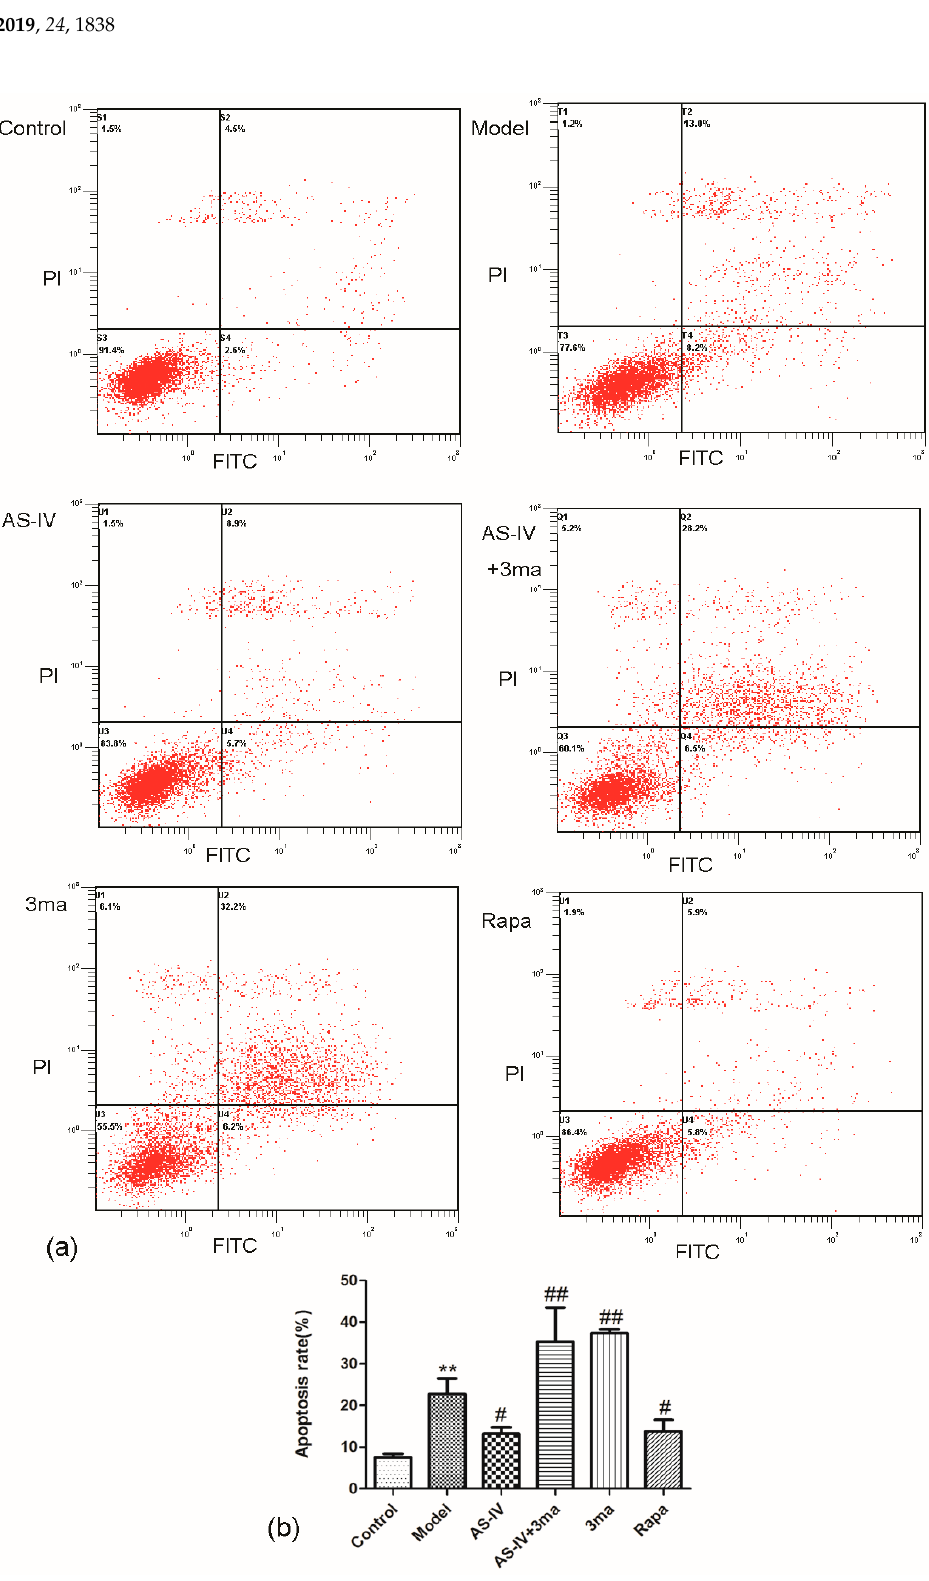
Figure 9. Astragaloside IV decreased the apoptosis rate by activating autophagy after OGD/R. The changes of the apoptotic rates in the HT22 cells by OGD/R with different treatments examined via flow cytometry with Annexin V-FITC/PI staining (means ± SD, n = 3. ** p < 0.01 vs. control and # p < 0.05, ## p < 0.01 vs. model). ( a ) Representative photographs obtained from each group. ( b ) Quantitative assessment of apoptotic cell death.